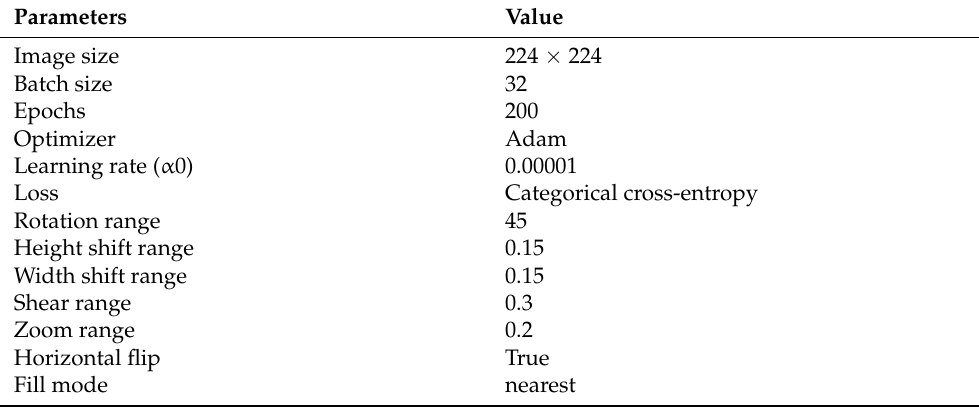
Table 2. Detailed hyperparameters of the experiment.